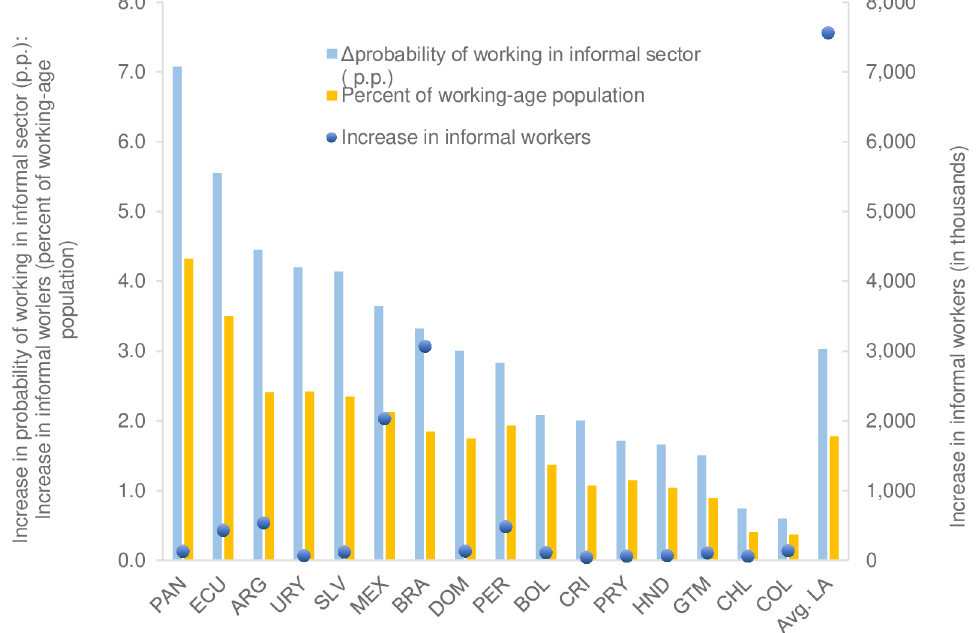
Fig 5. Latin America: Changes in the informality rate associated with declines in labor income compared to the pre- COVID-19 level. Sources: Estimates from household or employment surveys: Argentina—EPH (2019), Bolivia—ECH (2018), Brazil—PNADC (2018), Chile—CASEN (2017), Colombia—GEIH (2018), Costa Rica—ENAHO (2018), Ecuador —ENEMDU (2018), El Salvador—EHPM (2019), Guatemala—ENEI (2018), Honduras—EPHPM—(2018), Mexico— ENIGH (2018), Panama—EPM (2017), Paraguay—EPHC (2018), Peru—ENAHO (2018), Dominican Republic—ENCFT (2017), Uruguay—ECH (2019). The EPH survey in Argentina only has urban coverage. The blue bar indicates the increase in percentage points of the probability of working in the formal sector associated with declines in labor income due to the pandemic (left axis); the yellow bar indicates this increase of informal workers as a percentage of the working- age population (left axis); the green circle indicates the increase of informal workers in absolute numbers (right axis). p. p.: percentage points.